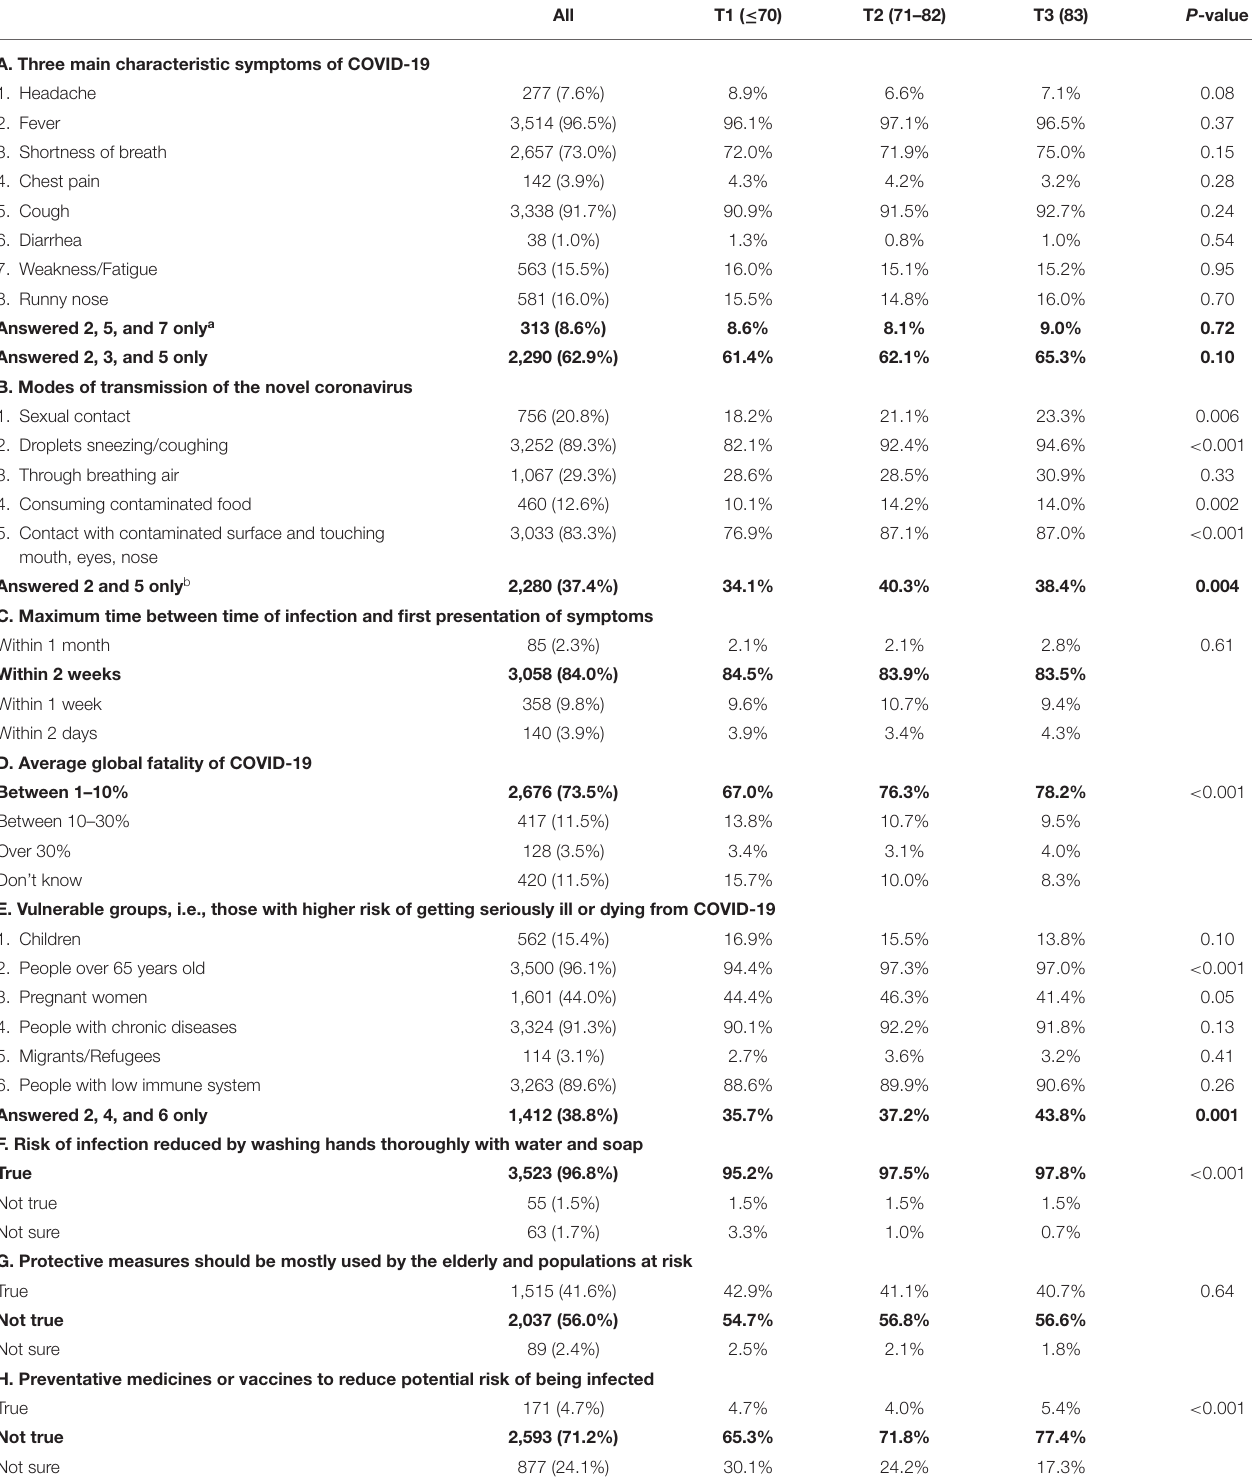
TABLE 2 | Knowledge about symptoms, virus transmission, personal, and public health response by tertiles of self-assessment of knowledge on a 0–100 scale ( N =